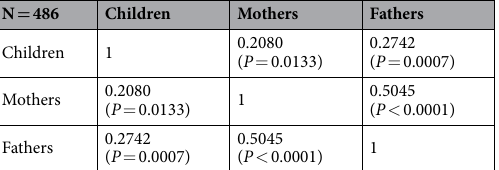
Table 2. Correlations between the level of urinary NNAL in children, mothers, and fathers. Log-transformed, Creatinine-corrected cotinine.